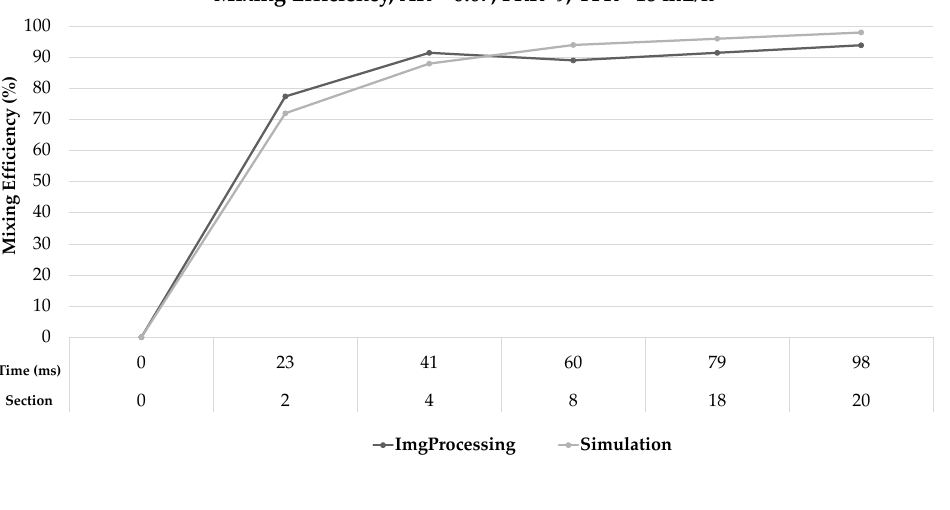
Figure 8. Comparison between simulation results and those obtained in image processing: AR = 0.67, FRR = 9; TFR = 18